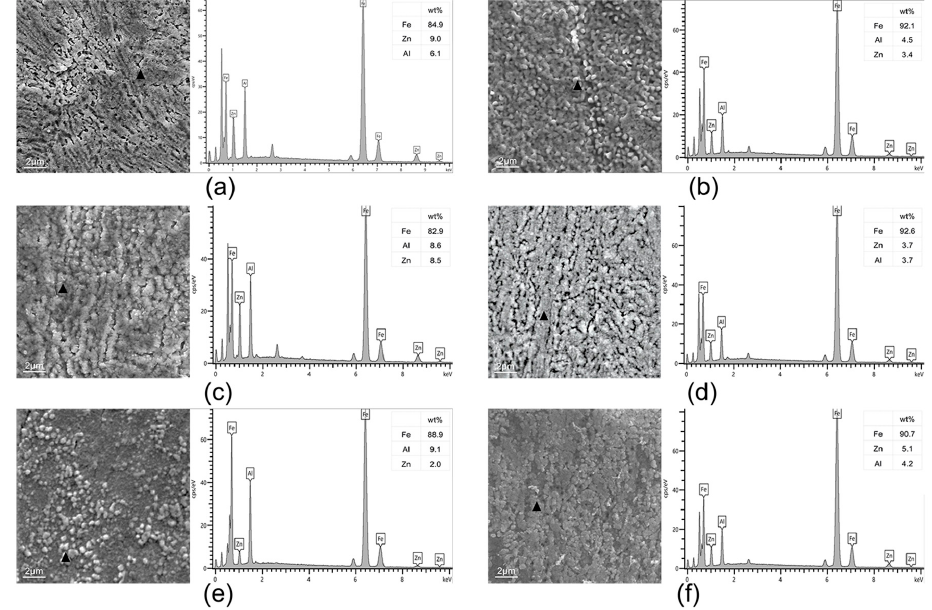
Figure 10. SEM micrographs and EDS analyses of the inhibition layer on the steel/coating interfaces of all samples. ( a ) 1#, ( b ) 3#, ( c ) 4#, ( d ) 2#, ( e ) 5#, ( f ) 6#.